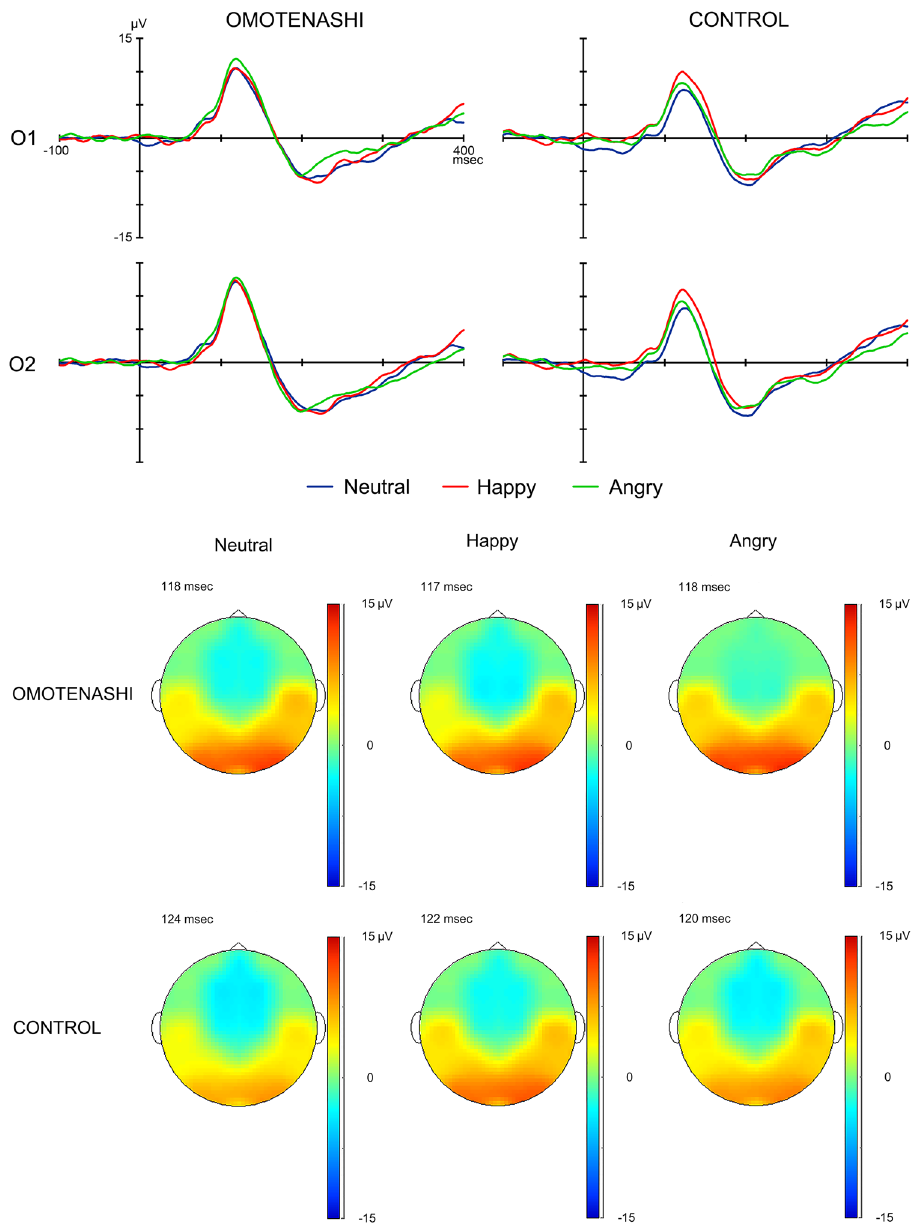
Figure 1. The grand-averaged waveforms of P100 at O1 and O2 of the left and right occipital areas (upper), and the topography map of P100 (lower) for Neutral, Happy, and Angry in OMOTENASHI and CONTROL.